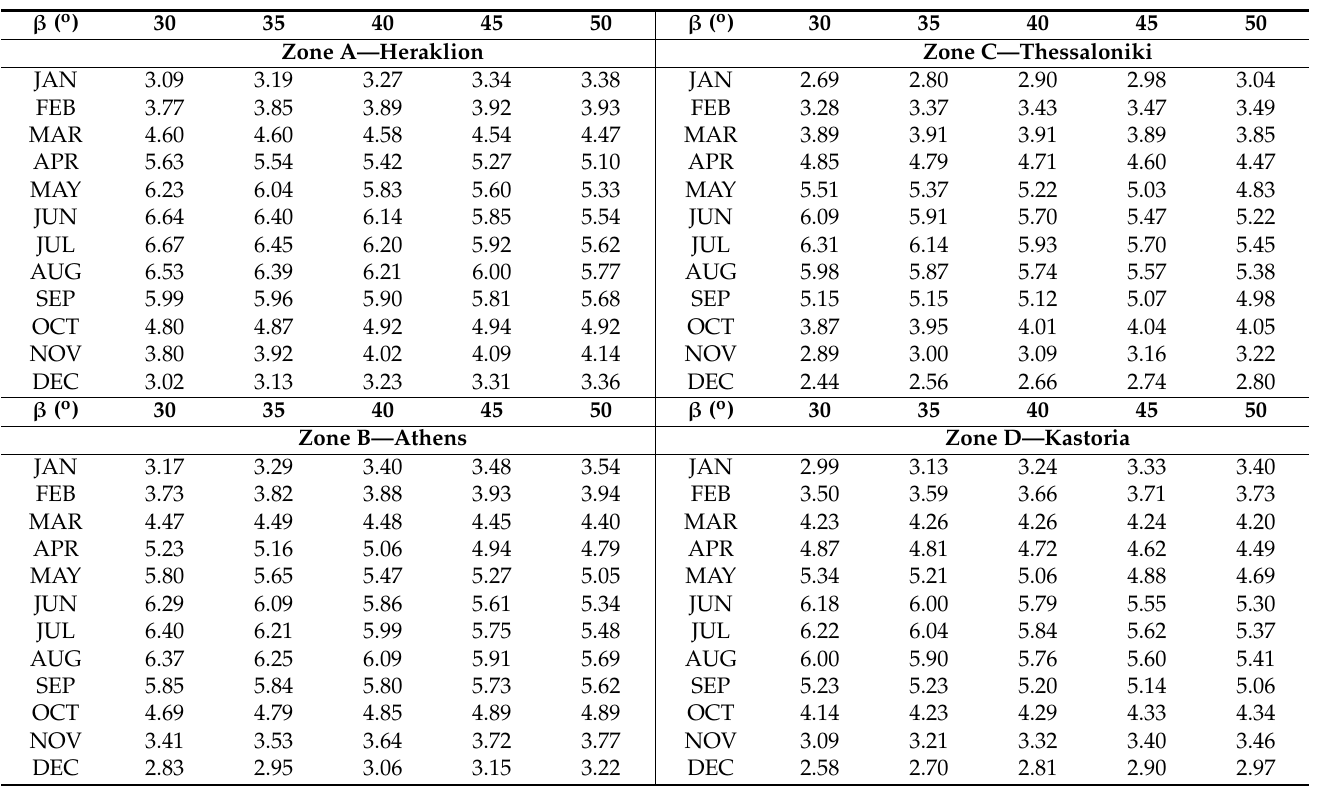
Table 5. Daily solar energy on the tilt surface (H T ) for different tilt angles and locations in [kWh/m 2 ].